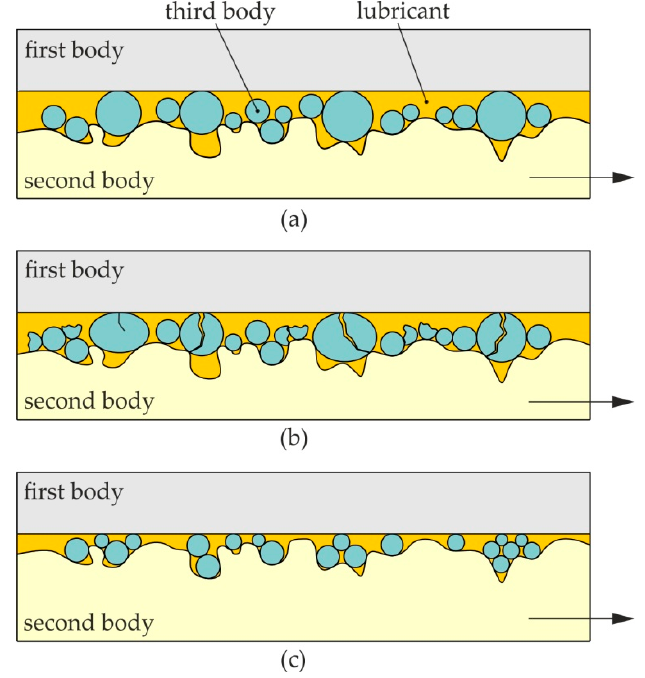
Figure 13. Schematic diagram of the contact interface in the presence of ( a ) large particles, ( b ) high pressure and ( c ) small particles and low-pressure conditions.